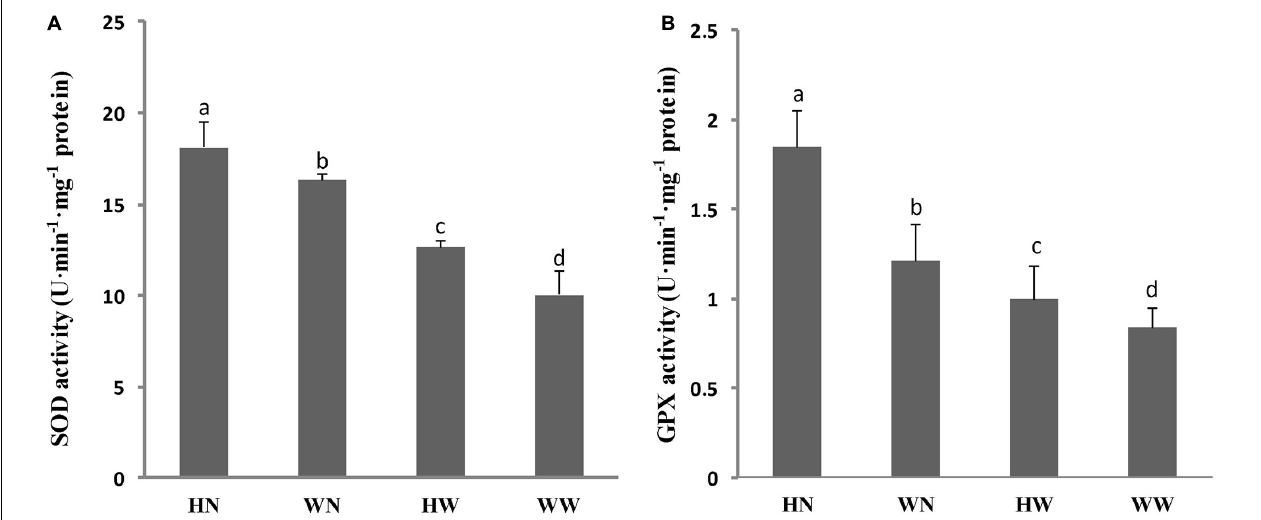
FIGURE 6 | Influence of H 2 O 2 pretreatment on SOD (A) , and GPX (B) activities in Arabidopsis leaves under different treatments. Three biological replicates per experiment. Data are represented as means ± SD. Means for each treatment that do not share a common letter are significantly different at P < 0.05, estimated with one-way ANOVA following SPSS. WW, pretreated with water and not salt-stressed; WN, pretreated with water and salt-stressed; HW, pretreated with H 2 O 2 and not salt-stressed; HN, pretreated with H 2 O 2 and